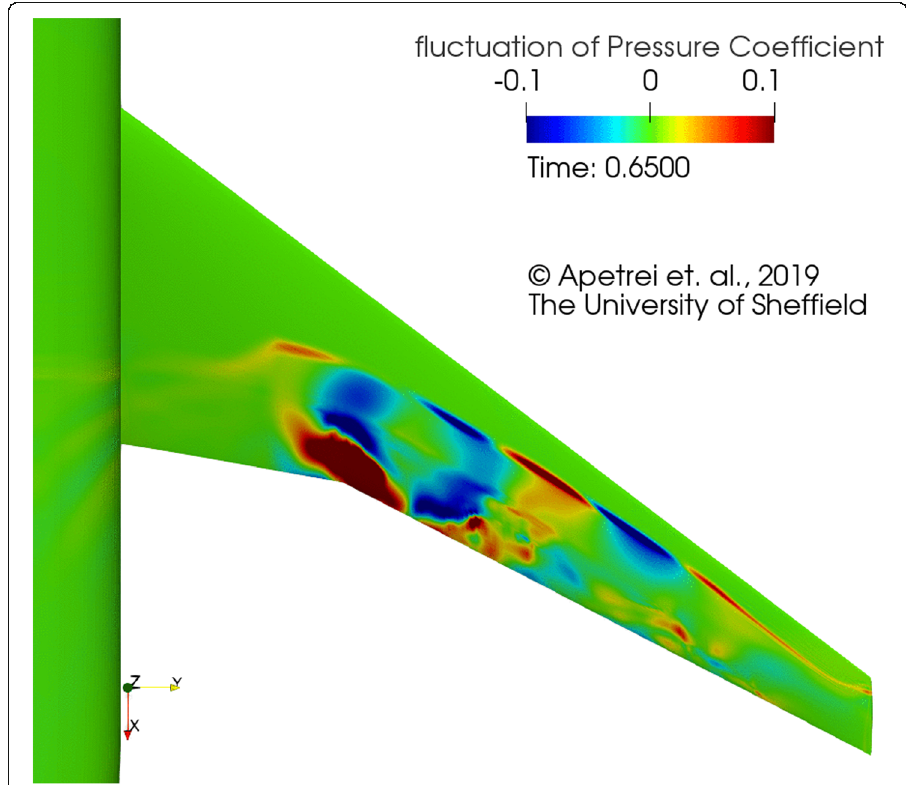
Fig. 12 Spanwise convection of the shock wave visualized through buffet cells at incidence α = 6° over 1 period of highest